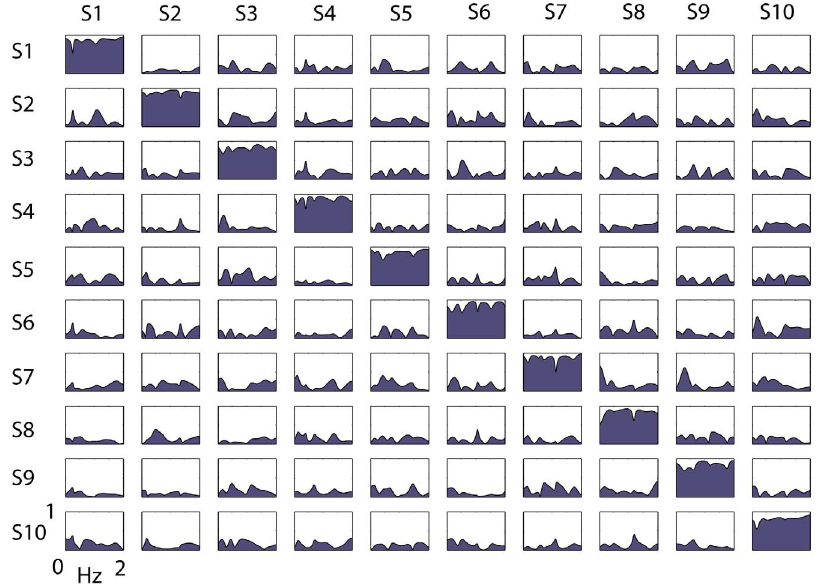
Figure 3. Generalized Partial Directed Coherence (GPDC). Example of multivariate (GPDC) coherence spectra matrix, related to the abdominal respiration signal in the music-associated condition, and in the 10 subjects (S1–S10) of the first collective measurement group on the first day. In each spectrum the abscissa reports the frequency in Hz, and the ordinate reports the coherence, from 0 to 1. Each subject is compared with all the other subjects and with him/herself in the diagonal. Note that the coherence in the diagonal is lower than 1, as each subject is compared with himself, but in the context of a multivariate model that takes into account also the remaining subjects.